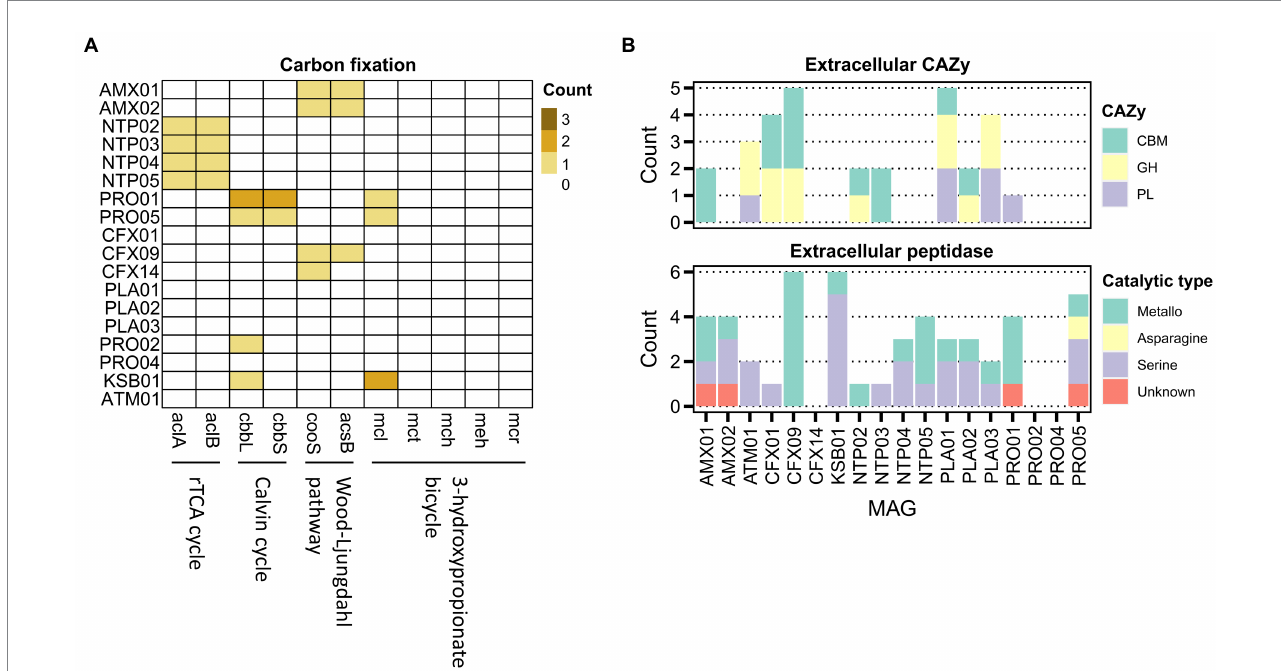
FIGURE 3 Distribution of functional genes for the carbon fixation (A) , and the genes encoding extracellular carbohydrate-active enzymes (CBM, carbohydrate-binding module; GH, glycoside hydrolases; PL, polysaccharide lyases) and peptidases (B) in the core